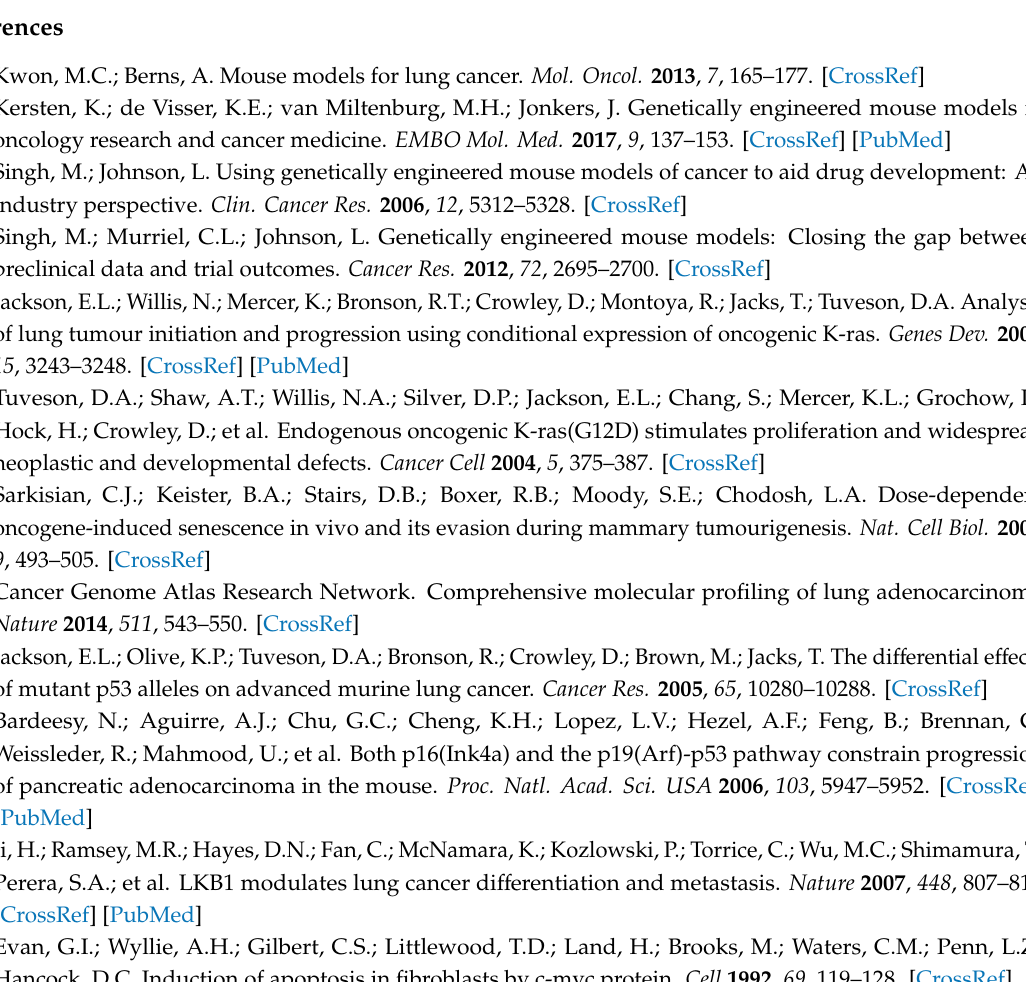
Figure S1: Generation of Rosa26 DM.lsl-MYC mice. Figure S2: Statistical analysis of KRAS and MYC alterations in human LuAd. Figure S3: High-resolution images of K-only and KM 2 tumour histology. Figure S4: In vitro validation of KM 2 LuAd progression signature